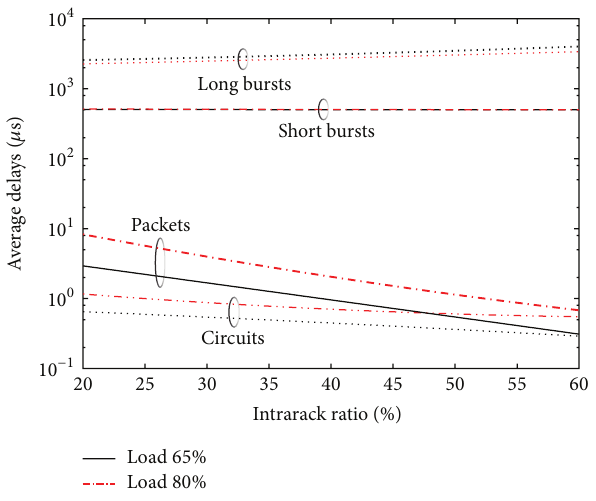
Figure 8: Average delays in the HOS network as a function of the IR at 65% and 80% of offered load.